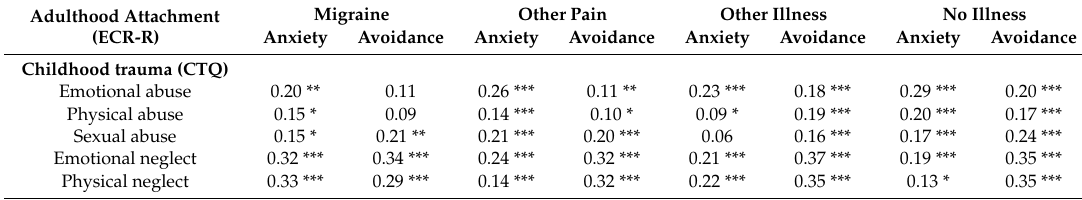
Table 3. Spearman correlation coe ffi cients between individual types of childhood trauma and adulthood attachment in the research groups.